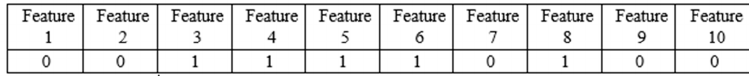
Figure 3. Representation of selected features